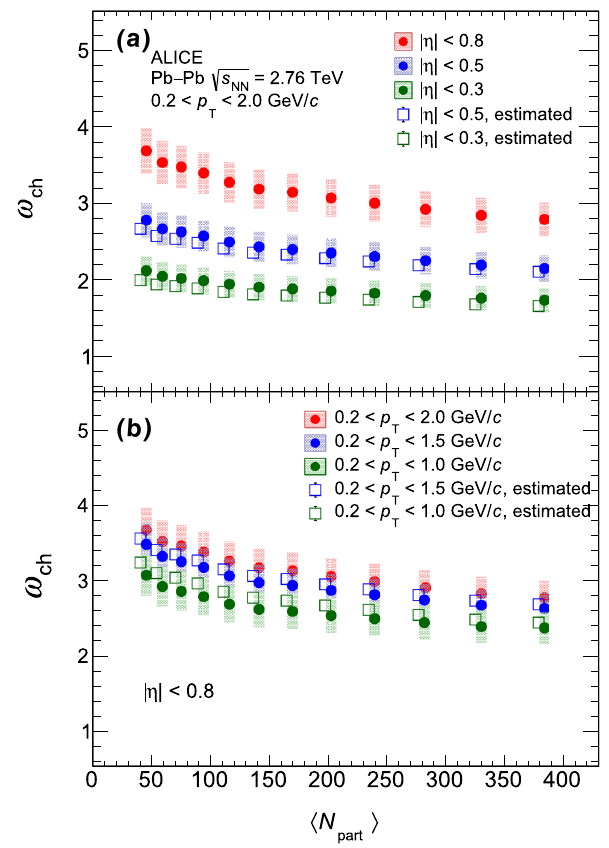
Fig. 2 Scaled variances of charged-particle multiplicity distributions for different η and p T ranges as a function of number of participating √ s NN = 2.76 TeV, shown nucleons measured in Pb–Pb collisions at in panels a , and b , respectively. The estimated ω ch for | η | < 0 . 3 and | η | < 0 . 5 are obtained from the experimental data of | η | < 0 . 8 by using Eq. 8. The estimated ω ch for 0 . 2 < p T < 1 . 5 GeV/ c and 0 . 2 < p T < 1 . 0 GeV/ c are obtained from the experimental data of 0 . 2 < p T < 2 . 0 GeV/ c , also by using Eq. 8. The statistical uncertainties are smaller than the size of the markers. The systematic uncertainties are presented as filled